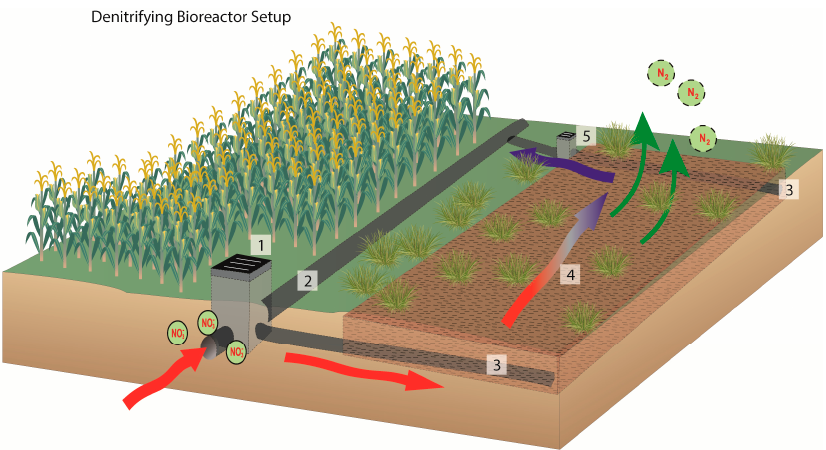
Figure 2. Baseflow in the drainage tile line is diverted into the bioreactor using flashboards in the diversion control structure (1), storm flows can bypass down the original tile line (2). Perforated pipes (3) at either end of the woodchip trench (4) allow water to enter and exit the bioreactor. The capacity control structure (5) contains a set of flashboards that allow for manipulation of the hydraulic gradient through the bioreactor.